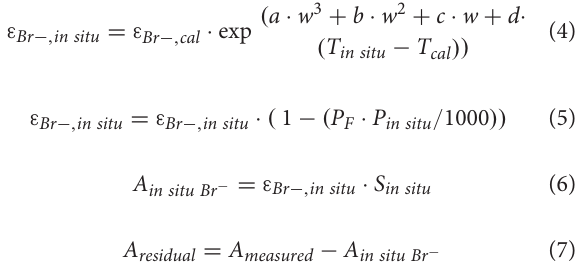
et al., 2015; Johnson et al., 2018). ε Br − , in situ is the molar ( T in situ , ◦ C), salinity (S in situ ) and pressure (P in situ , dbar). The parameters a , b , c , and d are regression parameters of 1e − 07, − 9e − 05, 0.0016, and 0.0212, respectively.